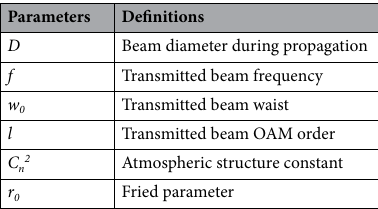
Table 1. Parameter definitions.